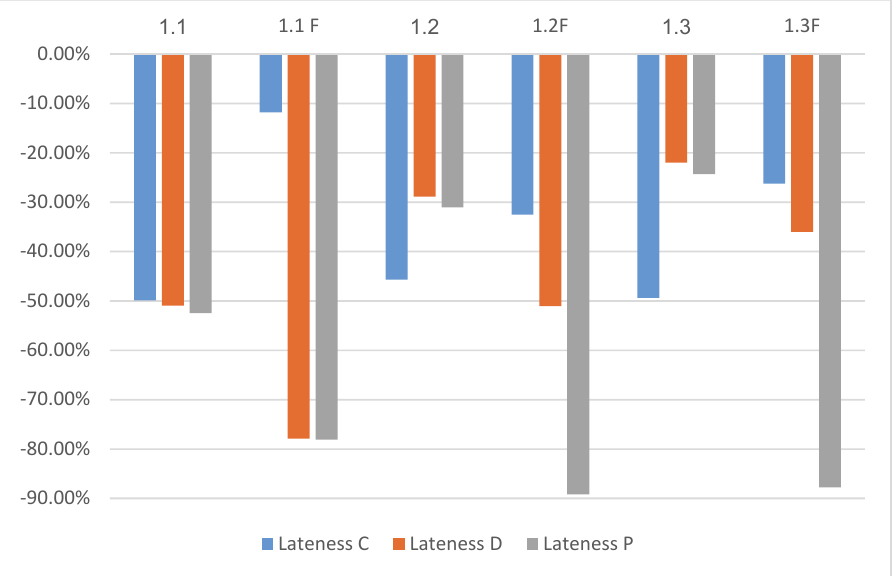
Fig. 4. Results comparison with